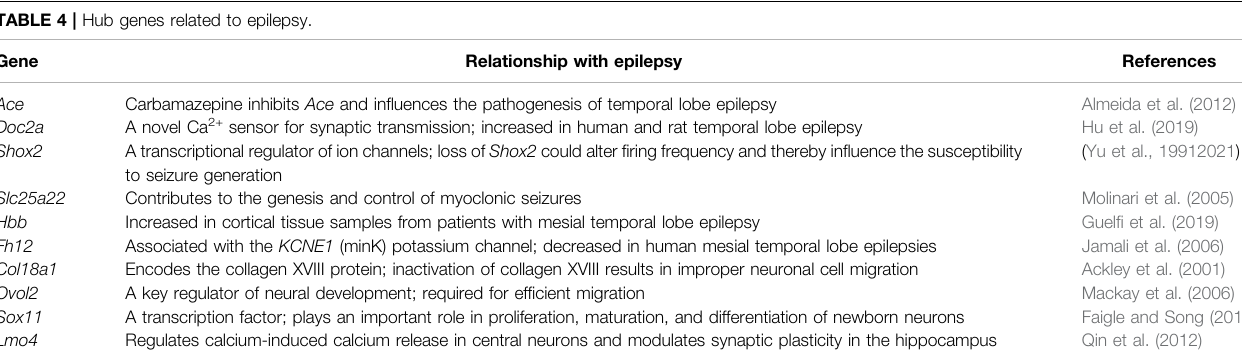
TABLE 4 | Hub genes related to epilepsy. Gene Relationship with